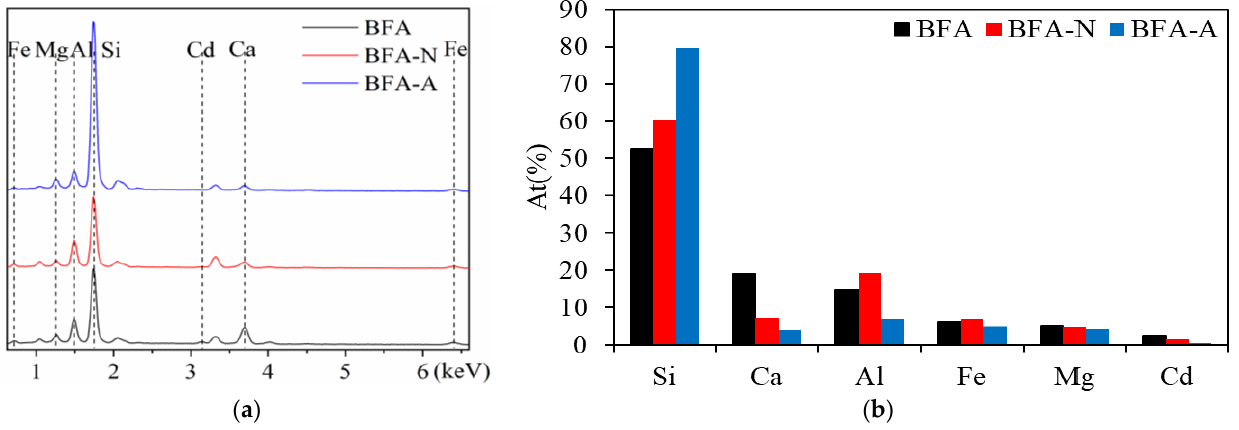
Figure 11. EDS of BFA, BFA-N, and BFA-A after adsorbing Cd, ( a ) energy spectrum diagram, ( b ) ratio of the elements.